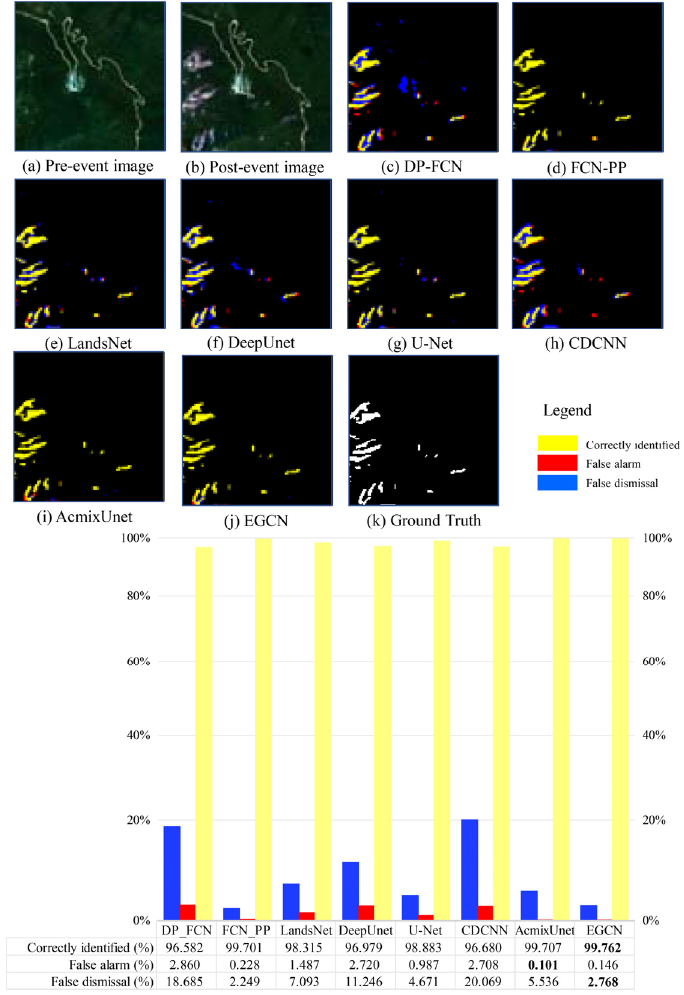
Figure 9. Comparison of the identification results of 8 methods in Region C. Bold values mean the highest number of the corresponding evaluation criterion. Table 5. Environmental classes and landslide sizes in three